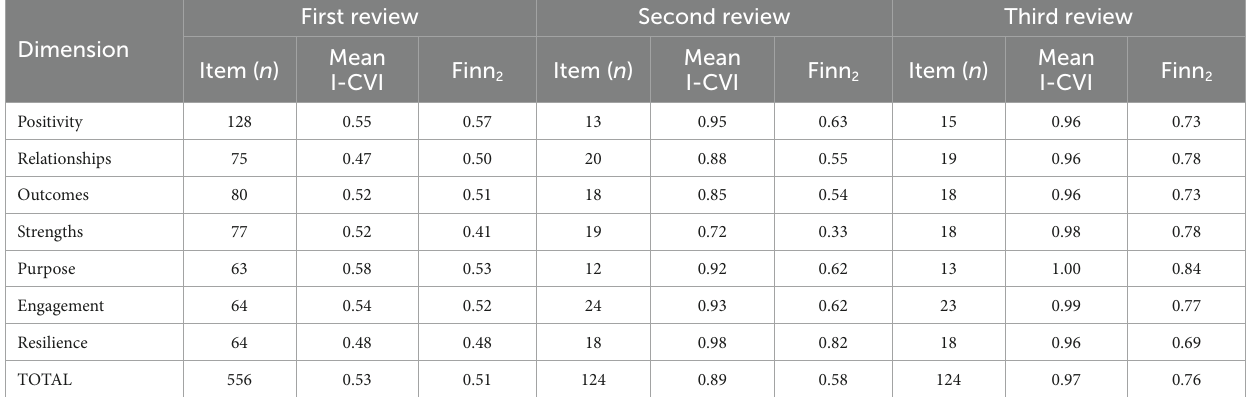
TABLE 2 Number of items, mean item-content validity index (I-CVI), and Finn’s coefficients.